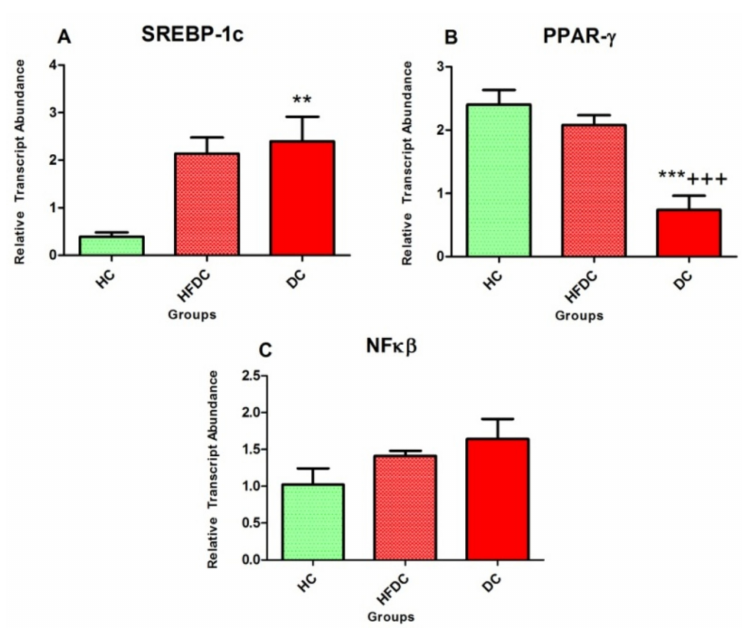
Figure 3. Assessment of liver and kidney function. ( A ) Serum SGPT levels; ( B ) Serum SGOT levels; ( C ) Serum creatinine levels; ( D ) Serum urea levels. Results are recorded as the mean of three replicates and denoted as mean ± SD ( n = 6 animals per groups). ** p ≤ 0.01 and *** p ≤ 0.001, healthy control group; +++ p ≤ 0.001, HFD control group; (Dunnett’s Multiple Comparisons Test). HC: Healthy control, HFDC: High fat diet control, DC: Diabetes control. SGPT: Serum glutamic pyruvic transaminase; SGOT: Serum glutamic oxaloacetic transaminase.